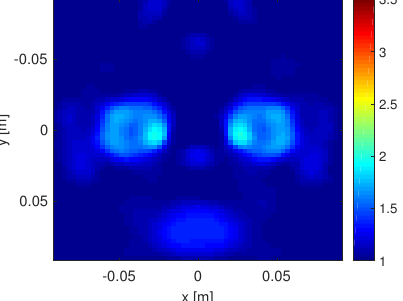
( d ) Reconstruction using the focused incident field for the circular sector measurement domain